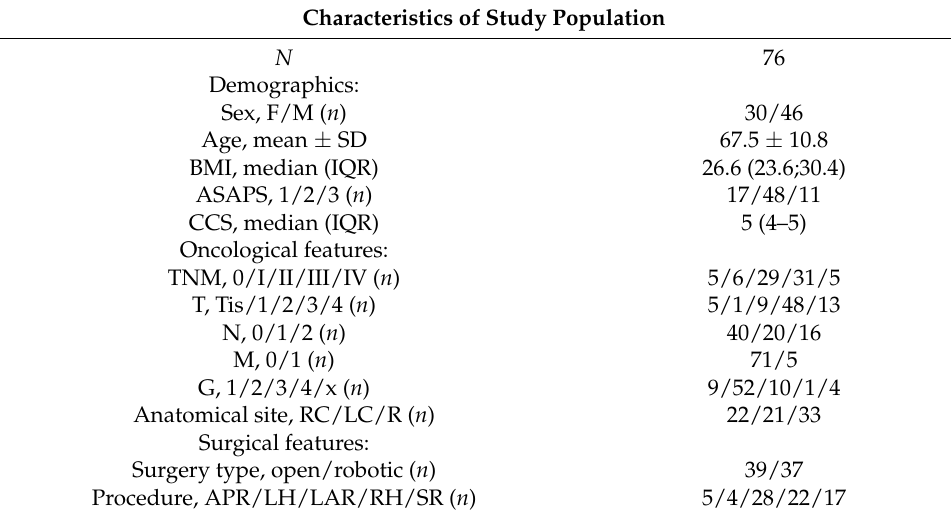
Table 1. Characteristics of study population (baseline cortisol quantification).